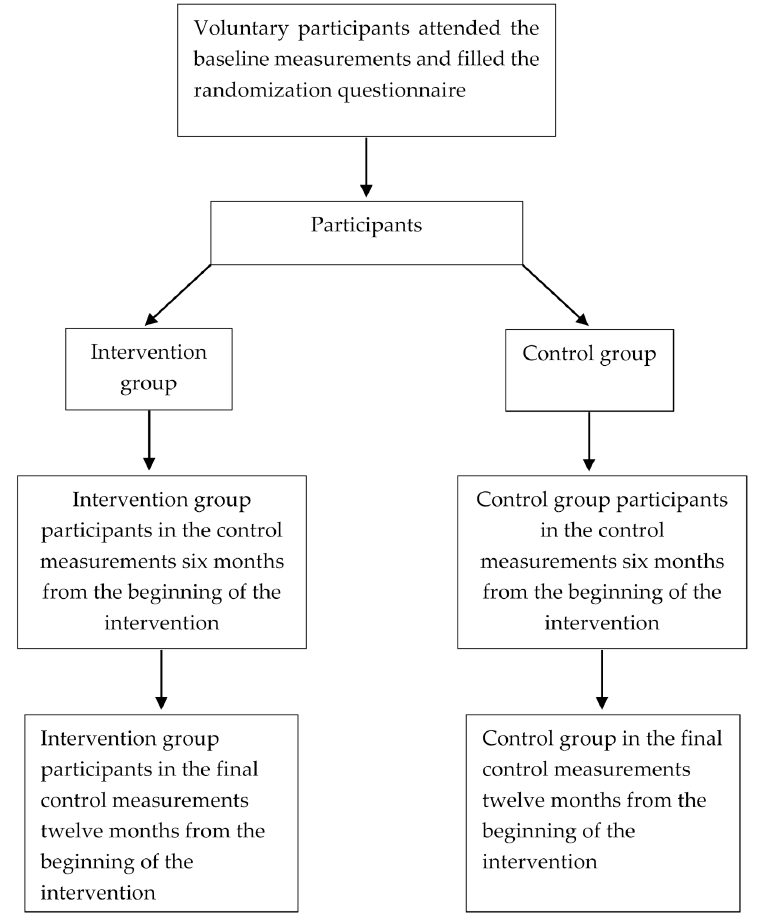
Figure 1. Participants in the different phases of the